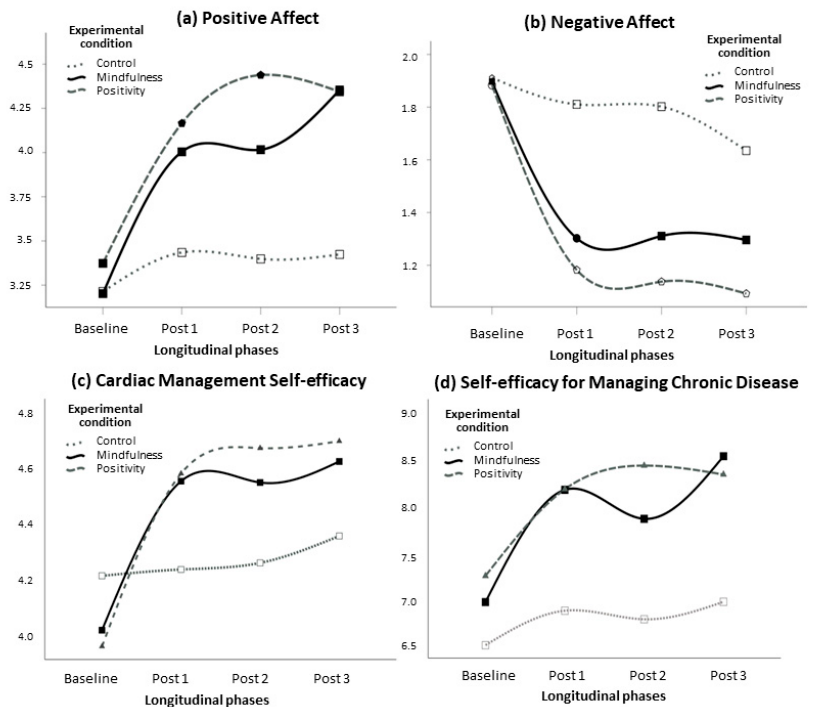
Figure 2. Longitudinal effects of experimental interventions (mindfulness and positive strengthening) and control on positive and negative affect, cardiac management self-efficacy, and self-efficacy for managing chronic diseases (depression and anxiety were inserted as covariates with values of 3.47 and 3.14, respectively).